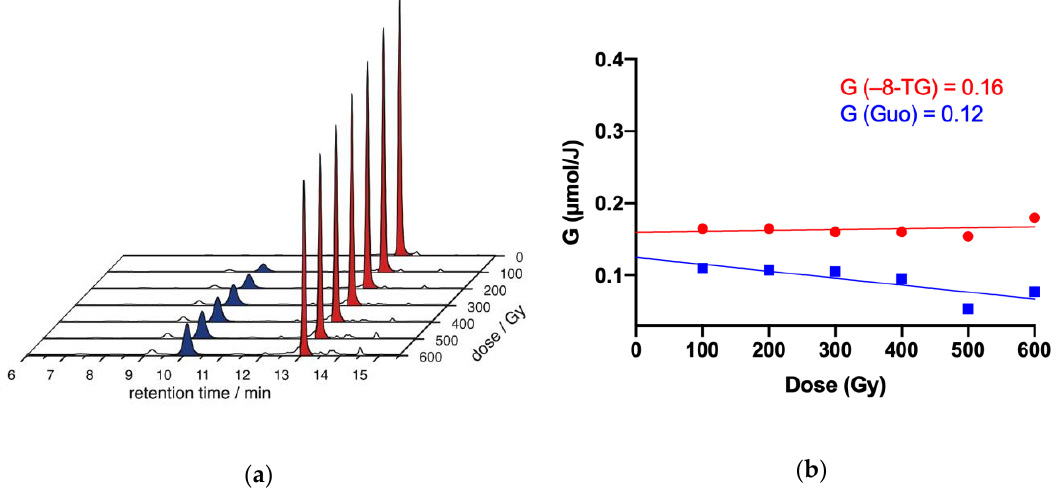
Figure 9. γ -radiolysis of 1 (0.3 mM) in N 2 O-purged water at a natural pH at a dose rate of 1.85 Gy · min − 1 . ( a ) HPLC runs of the reactions. The HPLC peaks of 1 are highlighted in red, while the peaks of guanosine ( 2 ) are highlighted in blue. ( b ) The chemical irradiation yields G ( − 1 ) ( (cid:8) ) and G ( 2 ) ( (cid:4) ) as function of the irradiation dose. The line extrapolated to a zero dose leads to the G values reported in the graph.